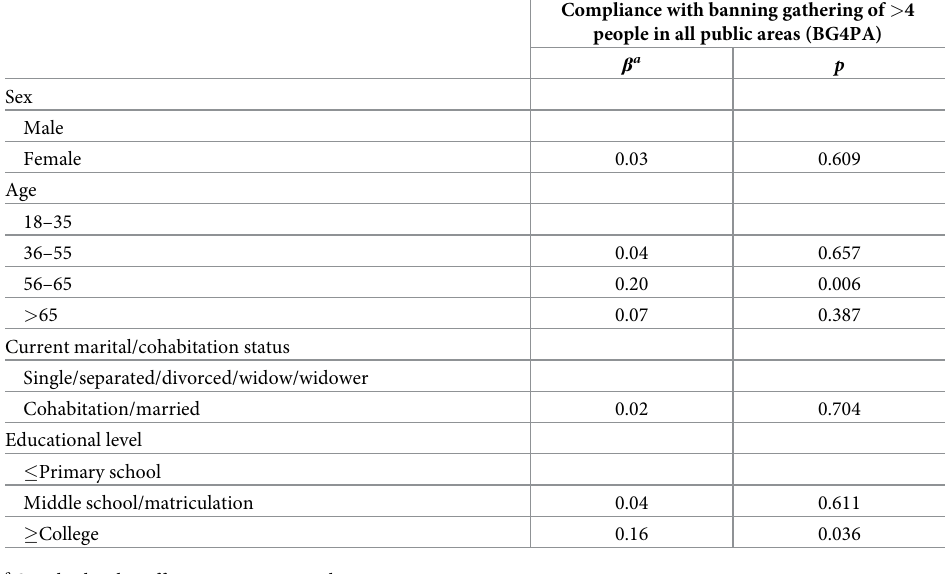
Table 3. Simple linear regression analysis on the background factors of compliance with BG4PA (n =